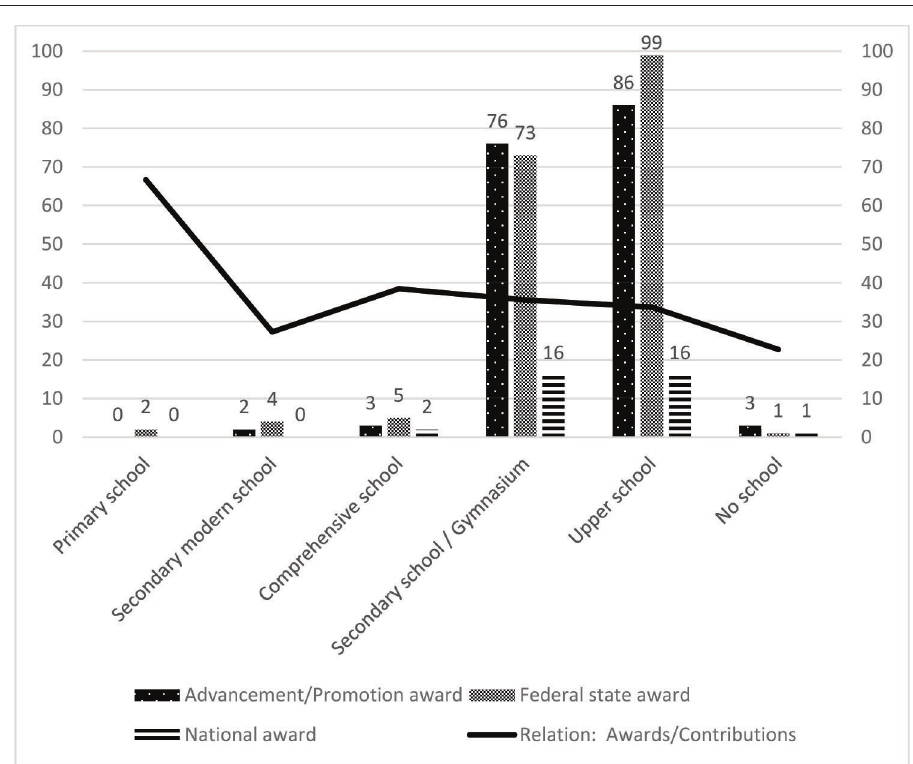
Figure 2: Who won which types of award in the